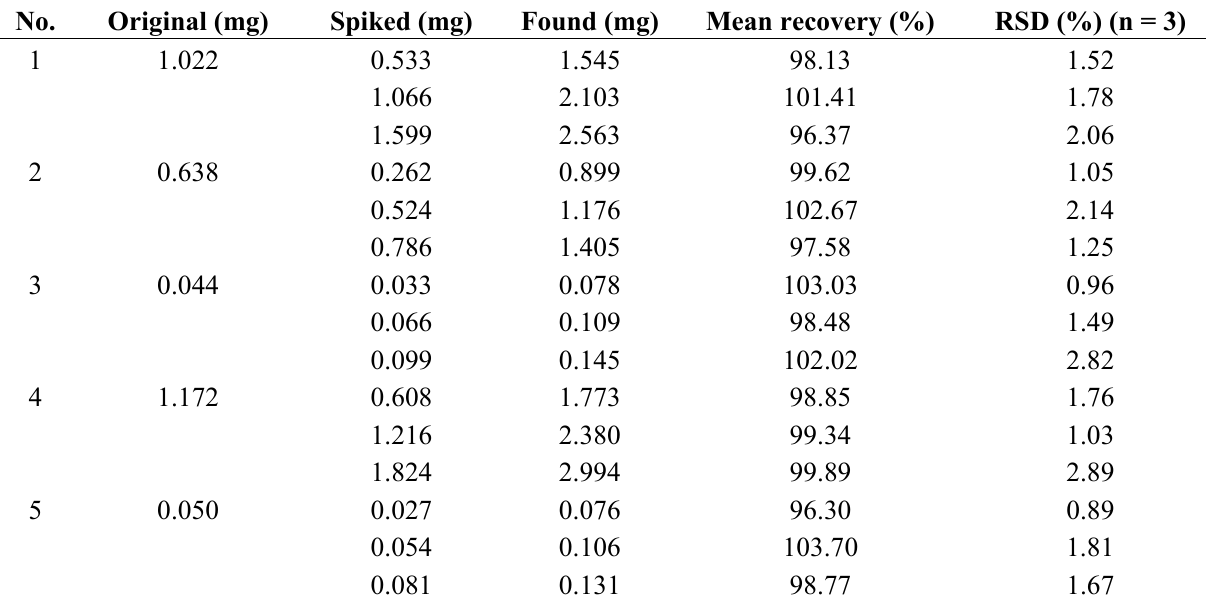
Table 2. Recovery experiment of analytical method for five components. ( 1 :